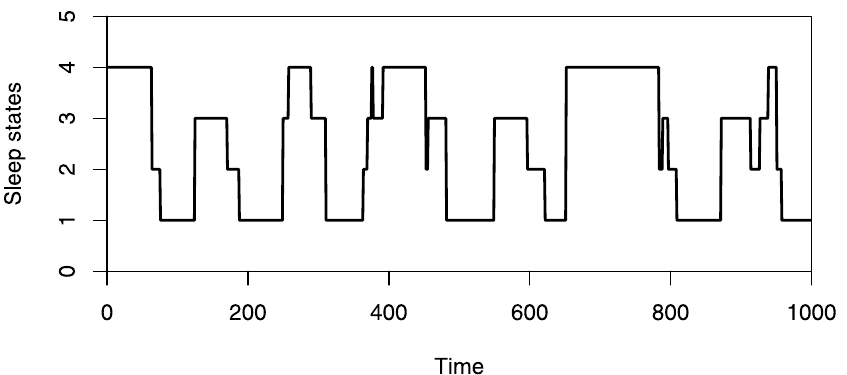
Fig 2. 1000 sleep data ( Y ) collected from the sleep state measurements of a newborn infant sampled every 30 t seconds.